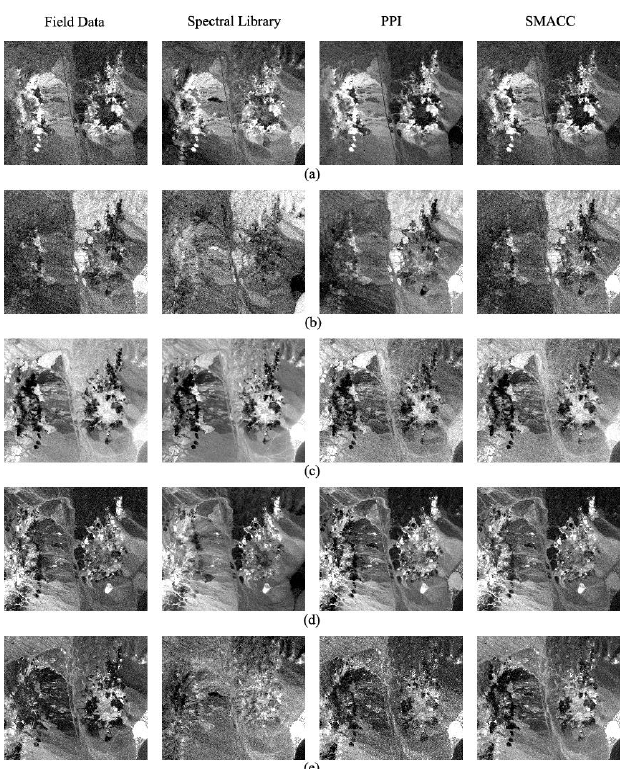
Figure 2. Abundance images for each of methods (a) alunite, (b)